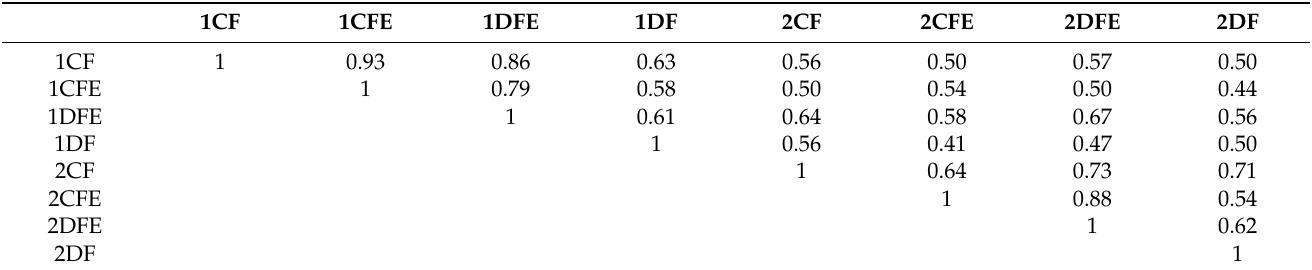
Table 3. Similarity of vascular plant species compositions between ecotone complex zones in the two plots (Jaccard